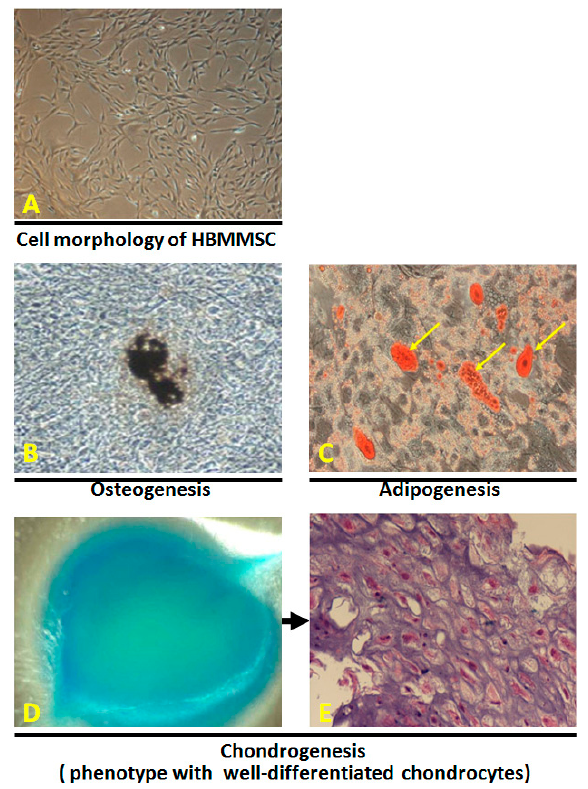
Figure 1. The morphology of HBMMSCs was showed by light microscopy ( A ). Osteogenic, chondrogenic, and adipogenic differentiation from HBMMSCs. Osteogenic differentiation from HBMMSCs was evidenced by cells morphology after 21 days of induction. Formation of mineralized matrix was shown by von Kossa staining ( B , shown at original magnification × 200). Adipocytic differentiation from HBMMSCs was evidenced by the formation of lipid vacuoles by oil-red O staining ( C , shown in phase-contrast photograph at original magnification × 200 and). Chondrogenic differentiation from HBMMSCs was evidenced by alcian blue staining ( D ), and by H&E staining for histological analysis ( E ).